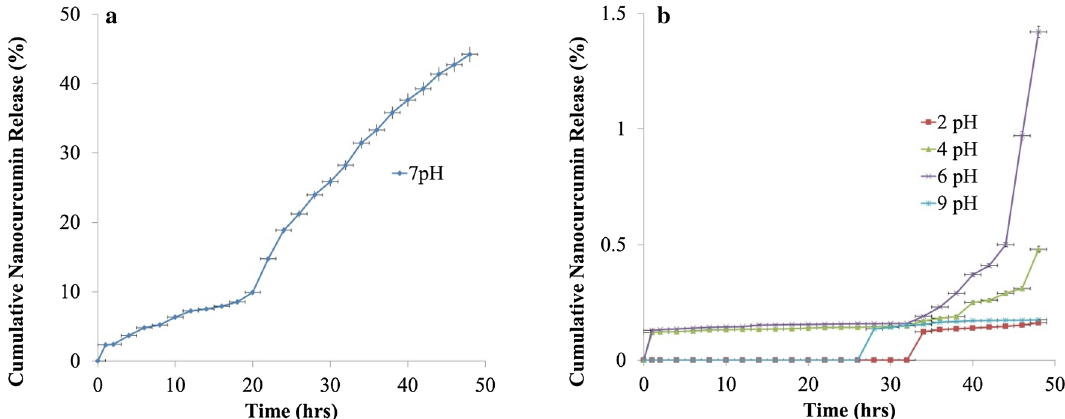
Figure 6. ( a ) Cumulative nanocurcumin release profile from influenza virosome monitored through the dissolution method at pH.7 ( b ) and pH. 2, 4, 6, 7, and 9 at the wavelength of 435 nm. Here, the error bar represents the standard error within the observations. The data were performed in